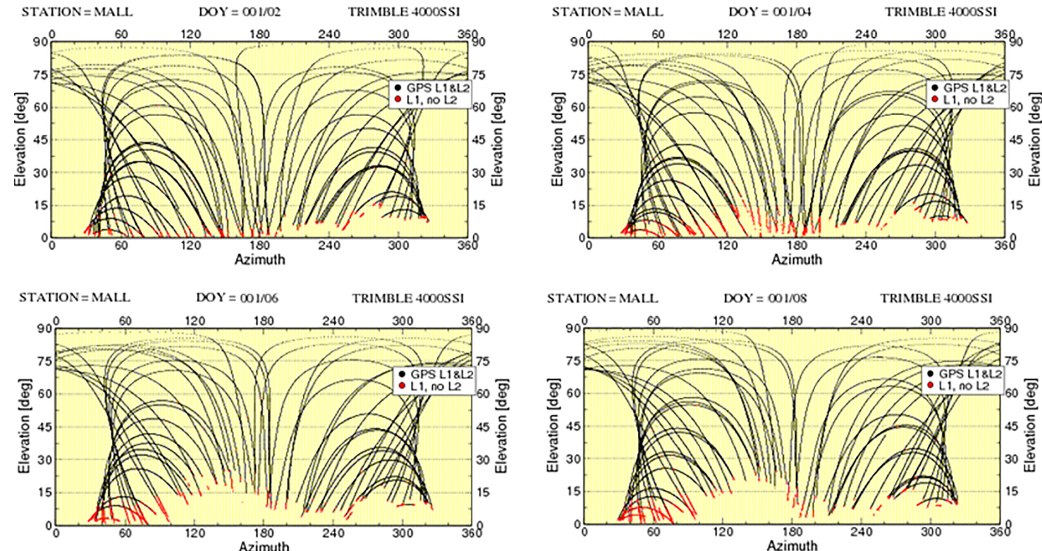
Figure 5. Low-elevation tracking problems at the MALL station during the period of 2003–2008. From top-left to bottom-right: January 2002, 2004, 2006 and 2008 (courtesy of the EPN Central Bureau, ROB).